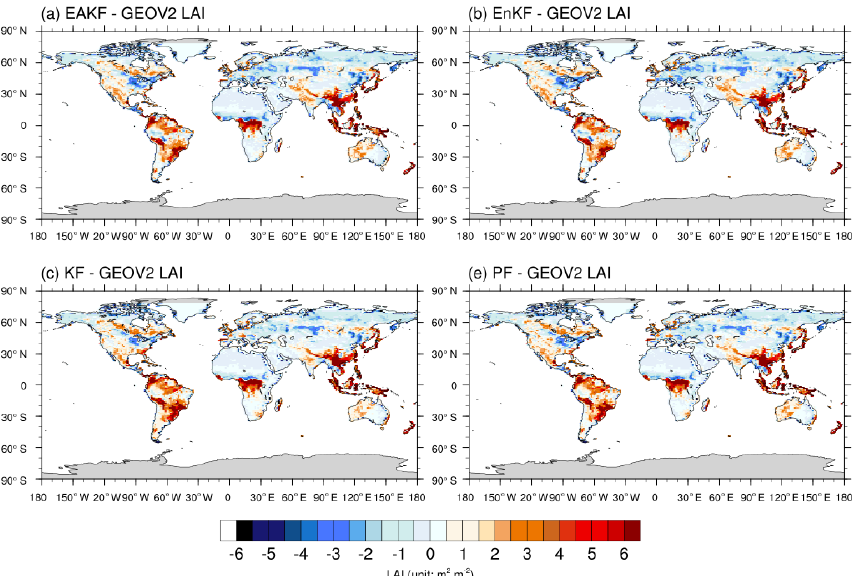
Figure 2. Differences between global LAI from assimilation experiments with the methods of (a) EAKF, (b) EnKF, (c) KF, and (d) PF and GEOV2 LAI in July 2002.